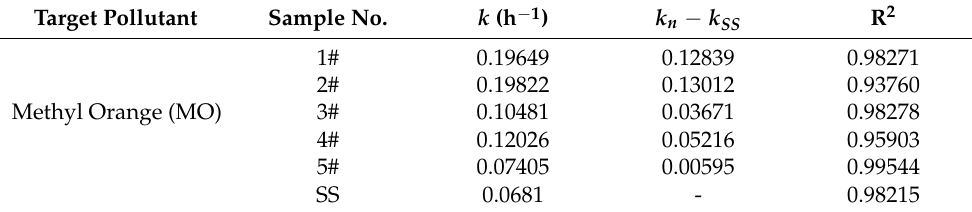
Table 3. Pseudo first order kinetic model parameters for degradation of MO (pH = 7) with different Samples. Target Pollutant Sample